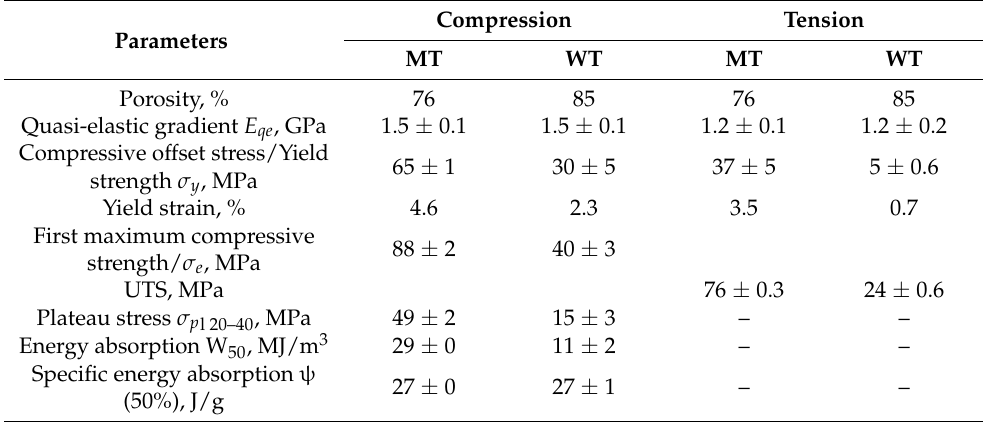
Table 3. Mechanical properties of the